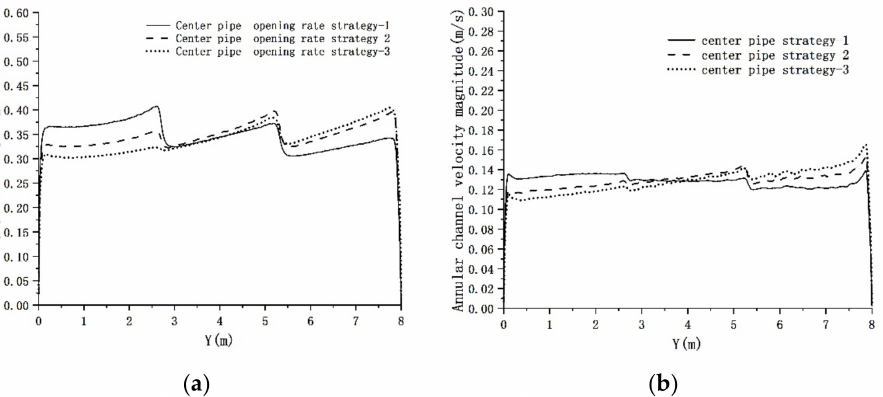
Figure 12. Radial velocity changes at different locations: ( a ) Radial velocity changes at the center pipe; ( b ) Radial velocity changes at the annular channel.